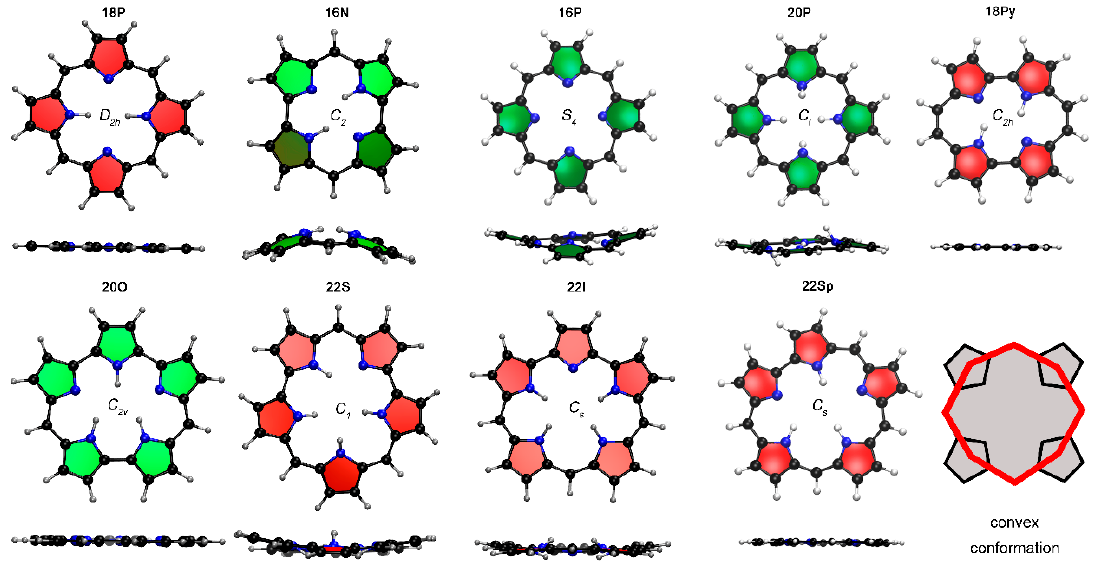
Figure 2. Hückel conformations computed for different porphyrinoids (top and side views). Red five-membered rings are linked to aromatic structures, whereas green ones to antiaromatic configurations. The symmetry point group together with a schematic representation of the convex conformer are also shown.